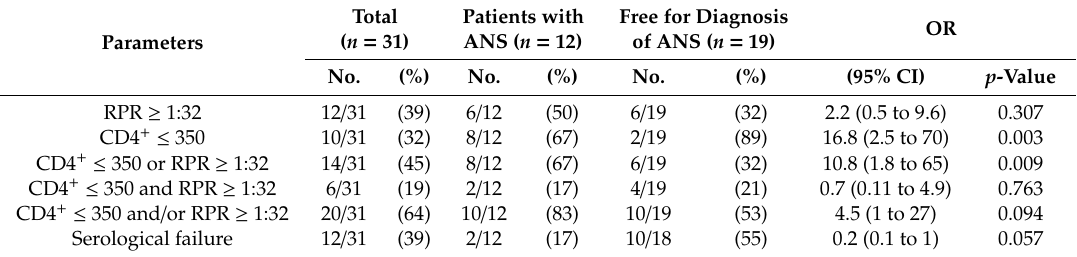
Table 1. Distribution of variables among participants and their statistical association with asymptomatic neurosyphilis (NS) diagnosis assessed by the Wilcoxon-Mann-Whitney test ( p -value < 0.05). Percentages were calculated as the number of patients with threshold significant on the whole analyzed positive and negative subjects. (CD4 + expressed in cells / mm 3